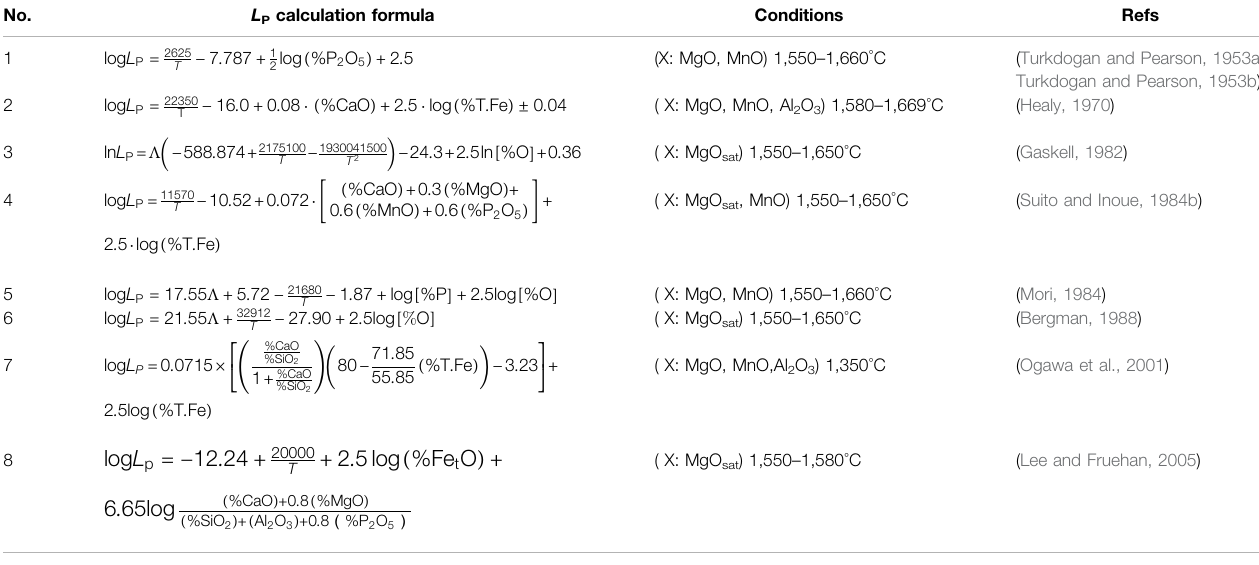
TABLE 1 | |Representative formulas for L P calculation in CaO-SiO 2 -P 2 O 5 -Fe t O-X systems. No. L P calculation formula